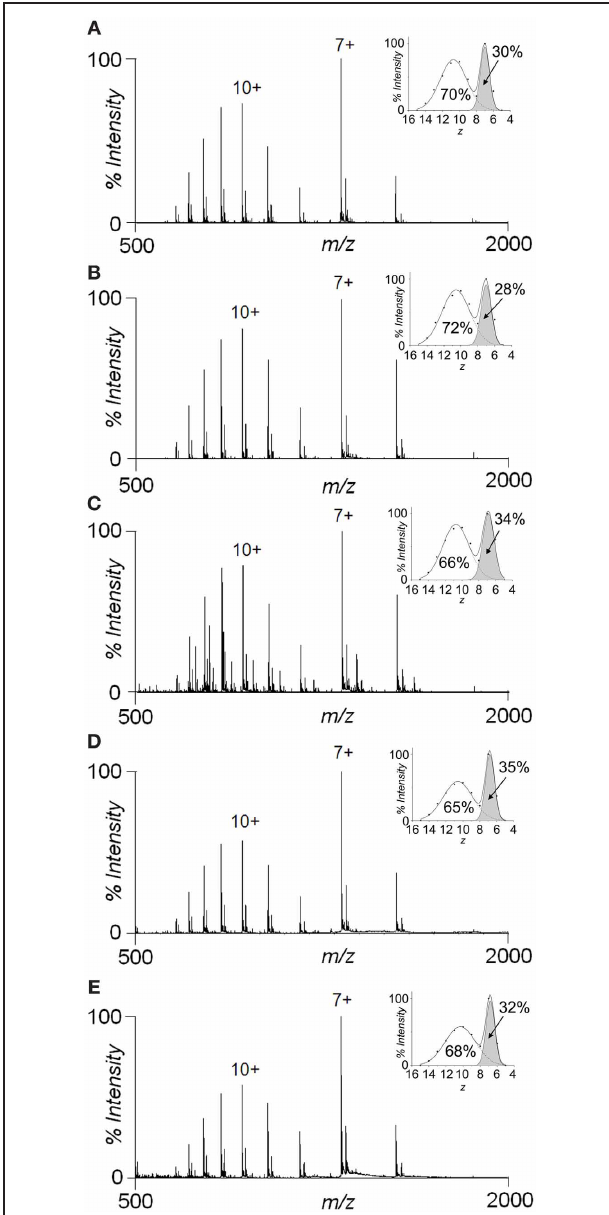
FIGURE 7 | Species distributions by ESI-MS and effects of organic solvents. Nano-ESI-MS spectra of 10 μ M protein in (A) 50mM ammonium acetate, pH 6.5; (B) 50mM ammonium acetate, pH 6.5, 30% acetonitrile; (C) 50mM ammonium acetate, pH 6.5, 50% acetonitrile; (D) 50mM ammonium acetate, pH 6.5, 30% methanol; and (E) 50mM ammonium acetate, pH 6.5, 50% methanol. The main charge state of each component is labeled by the corresponding charge state (7 + for the compact form and 10 + for the extended form). The insets show the gaussian fitting of the CSDs upon transformation to an x = z abscissa